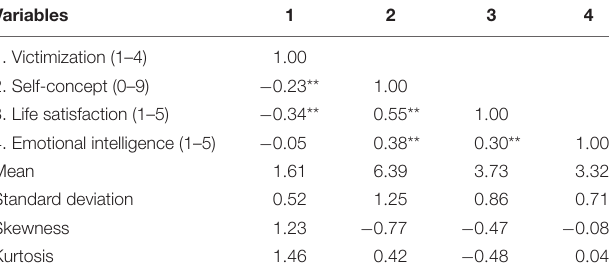
TABLE 1 | Pearson correlations and descriptive statistics of the variables.